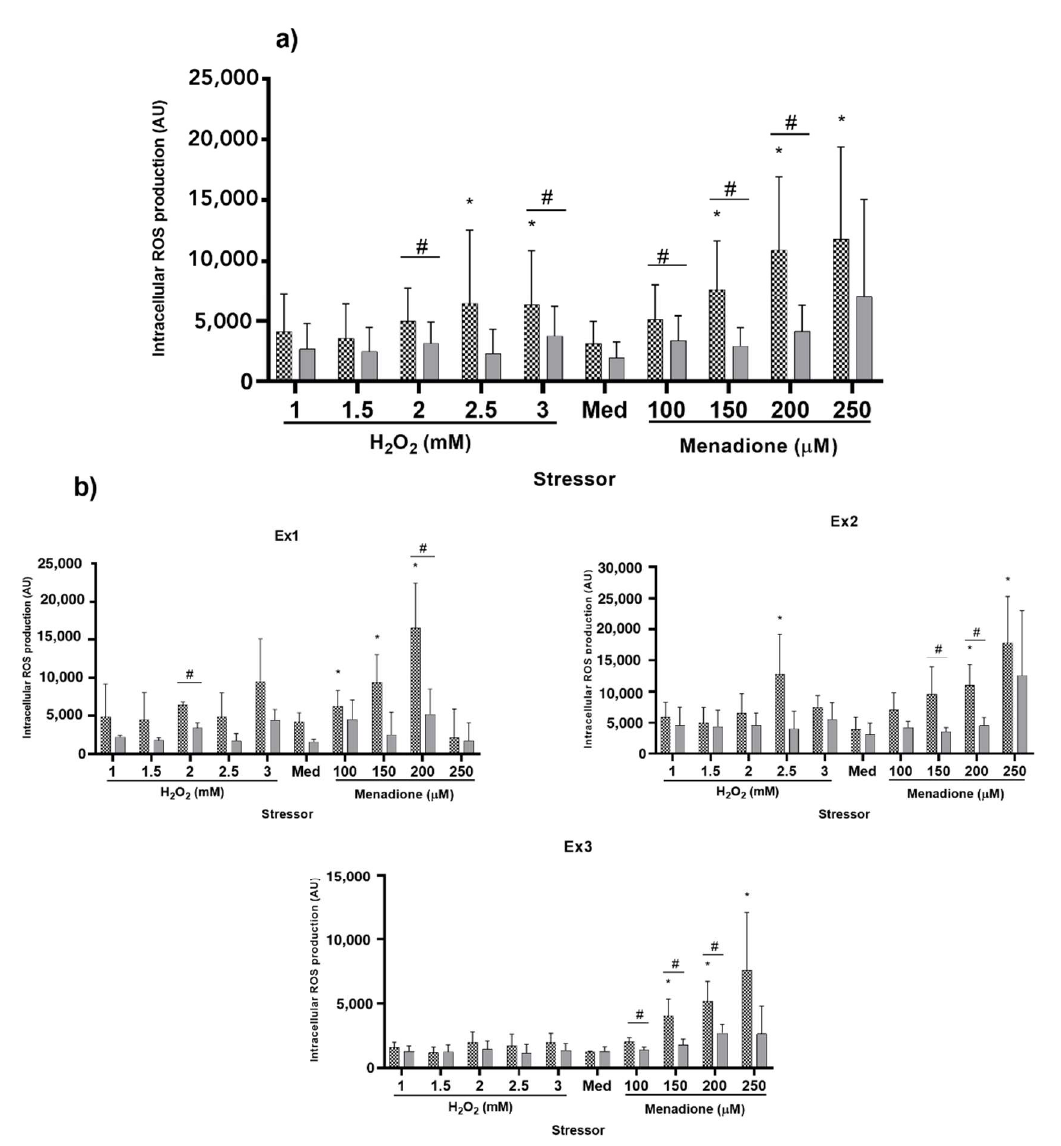
Figure 4. ROS production after an 18-h pre-incubation with: control (colorless growth medium containing no antioxidant, dotted bars) and trolox (colorless growth medium containing 2 mM trolox, solid grey bars), followed by a one-hour incubation with medium (Med; colorless growth medium containing no stressors) or different stressors (colorless growth medium containing either H 2 O 2 or menadione at the specified concentrations). ROS production in different conditions was determined by fluorescence measurement (measured in arbitrary units, AU). Different asterisks (*) indicate statistically significant differences in ROS production in stressed vs. non-stressed (medium) cells (i.e., stressor effect). Hashtags (#) represent a statistically significant decrease in ROS production after trolox incubation when compared to the same stressor treatments in control cells (antioxidant effect). p < 0.05. ( a ): Pooled data obtained in three independent experiments performed in a lapse of 6 months. ( b ): Individual data of each experiment (Ex1, Ex2 and Ex3) consisting of three independent replicates. Data represent means ± SD ( n = 9 in ( a ) and n = 3 in ( b )).